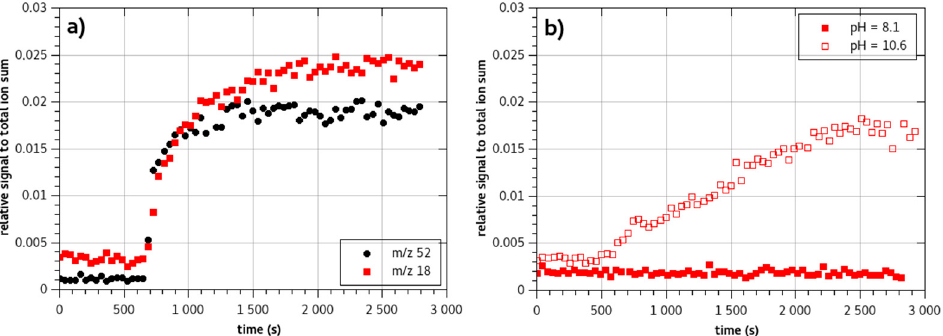
Figure 4. Time responses of the membrane system to ( a ) a solution of monochloramine (NH 3 Cl + m / z 52 -black dots- and NH 4+ m / z 18 -red squares- are presented) prepared at pH 8.1, ( b ) two ammonia solutions at pH 8.1 (filled red squares) and pH 10.6 (open red squares). Ammonia stock solution is added in the same quantity in the three solutions (solutions are prepared from 150 µL of ammonia stock solution in 200 mL water).